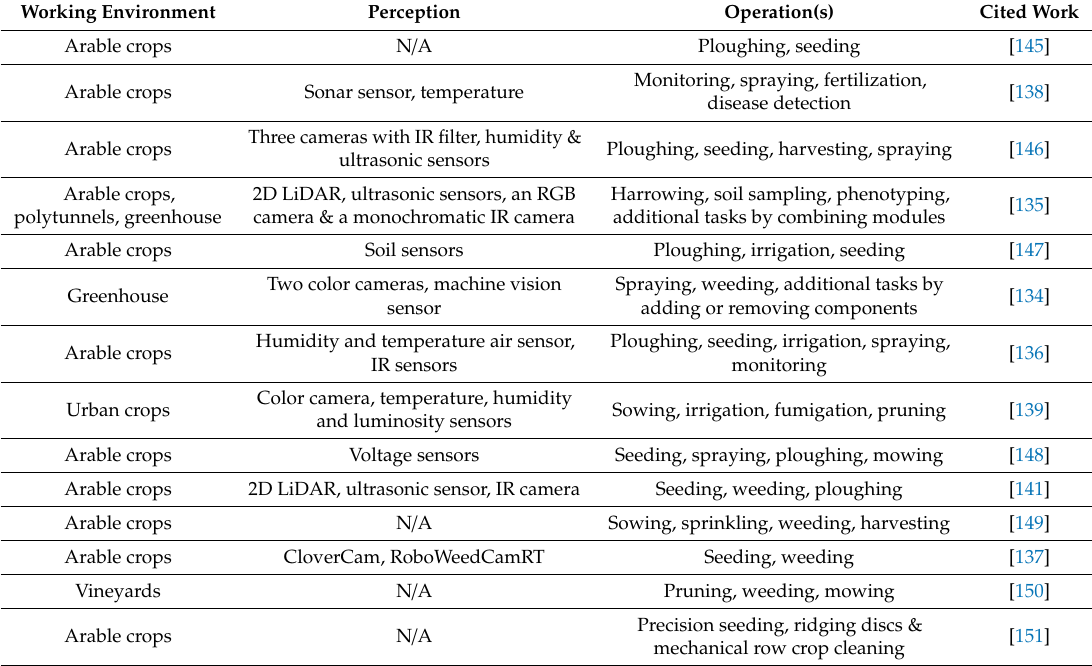
Table 9. Multi-purpose agrirobotic systems for various